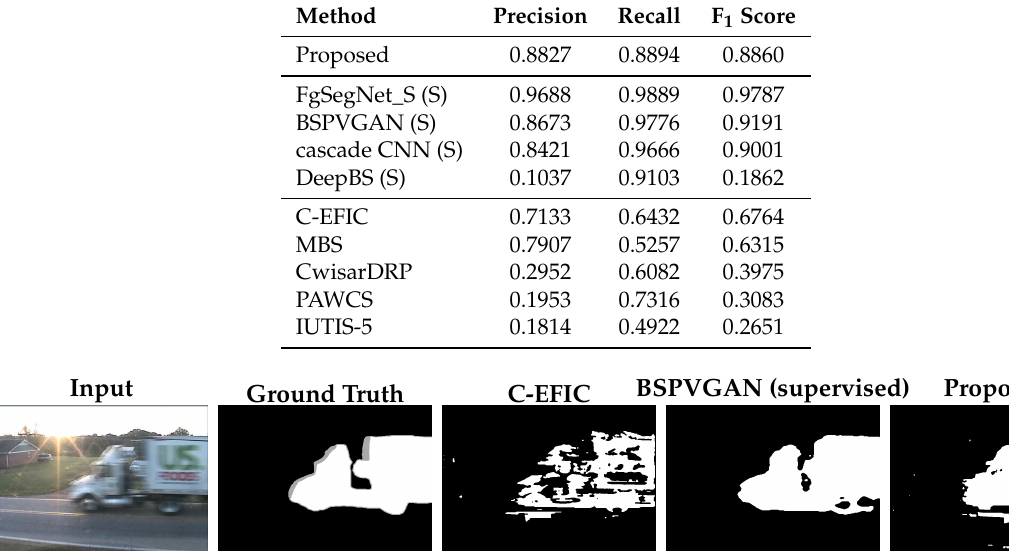
Figure 13. Foreground–background segmentation results for a handpicked frame from the publicly available ‘continuousPan’ sequence. Links to other methods can be found on the ChangeDetection.NET website